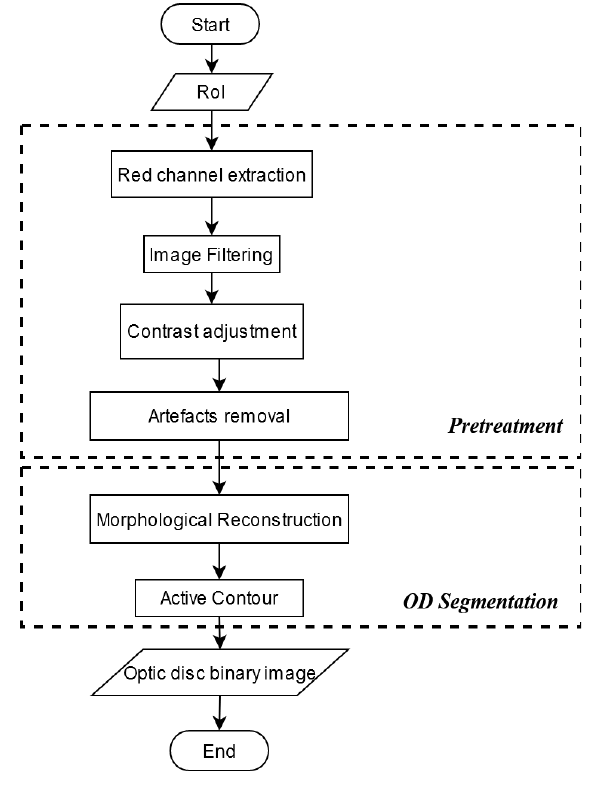
Figure 8 . The flow process of pretreatment.